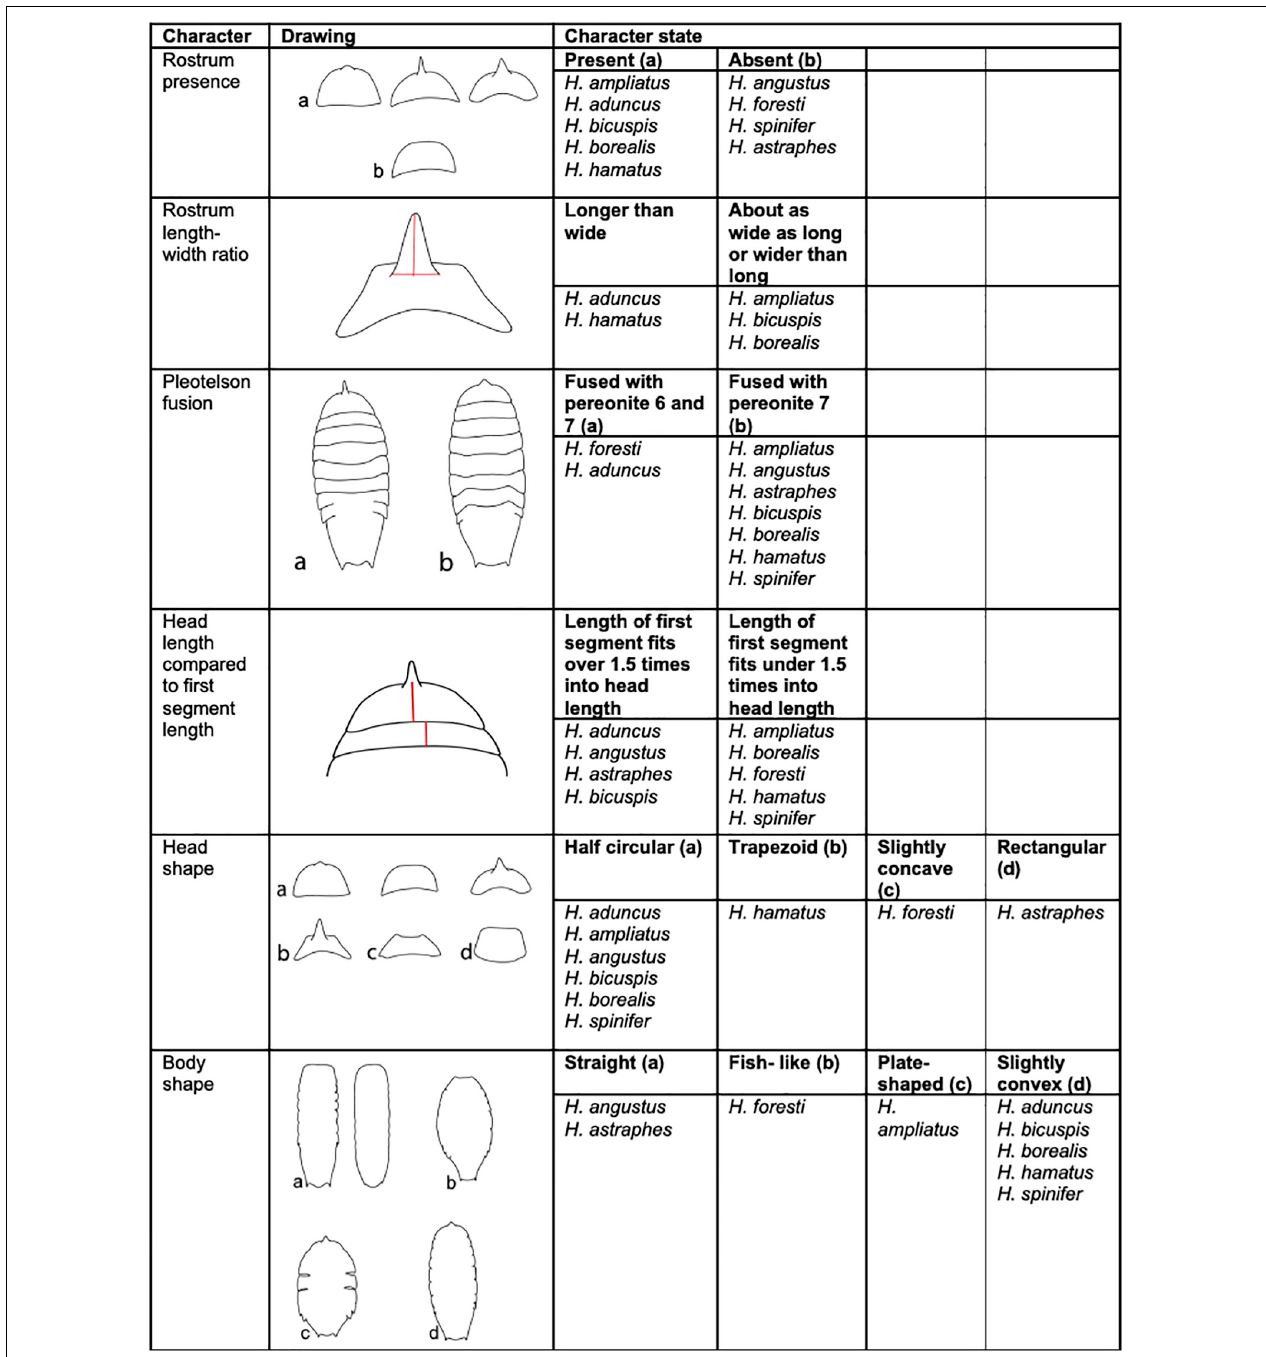
FIGURE 4 | Summary of characters and character states used to create the interactive identification key for species within Haploniscus occurring around Iceland (Modified after Lincoln, 1985a; Brökeland and Wägele, 2004; Brökeland and Svavarsson, 2017).